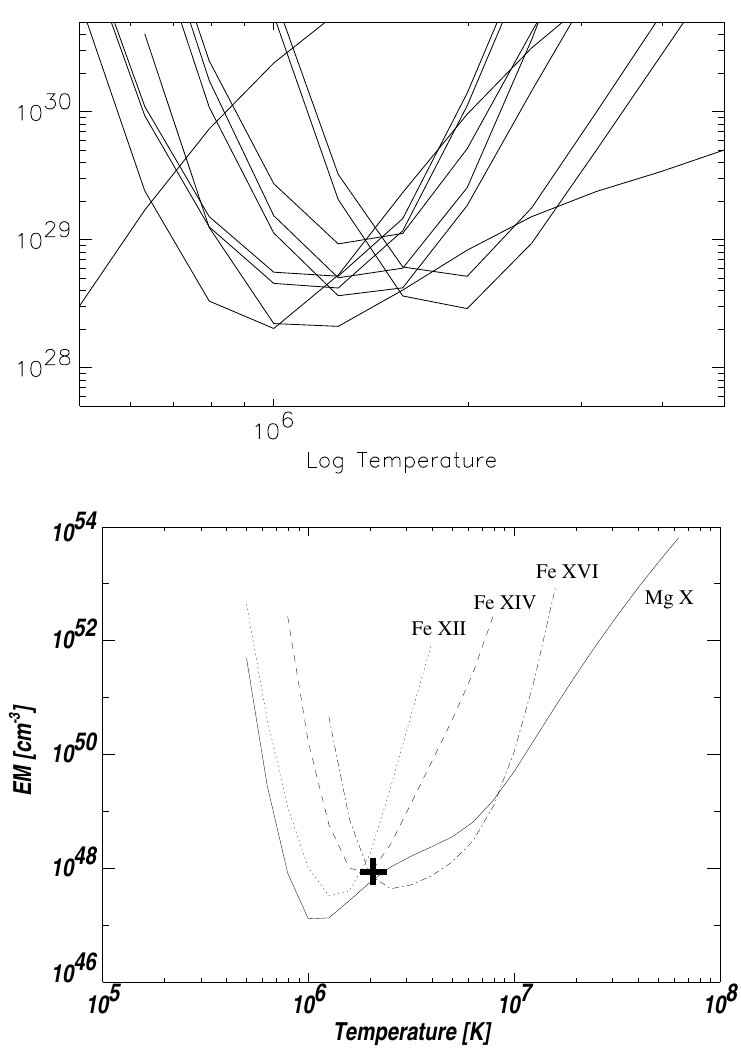
Figure 7: EM-loci plots for two different loop systems, one showing a multi-thermal structure (top, from Schmelz et al. , 2005, reproduced with permission, copyright by AAS), the other an almost isothermal one (bottom, from Di Giorgio et al. , 2003, reproduced with permission, copyright by ESO). The EM is per unit area in the top